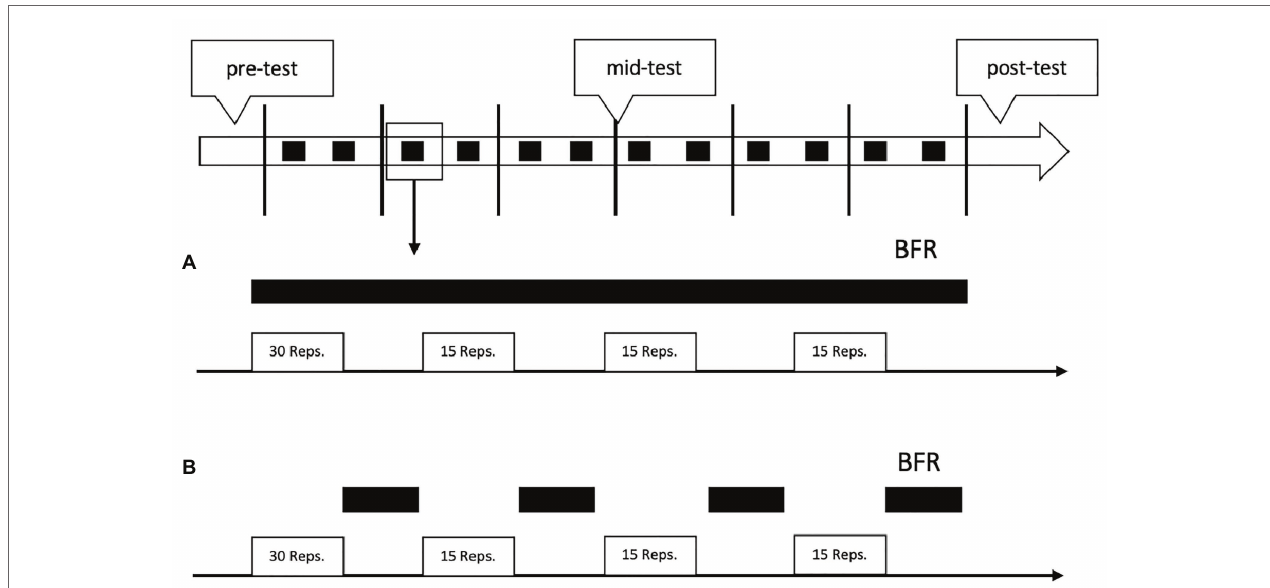
FIGURE 2 | Schematic overview of the study design and training protocol. The black squares in the top figure represent the blood-flow restriction (BFR)-trainings. The black bars in (A,B) indicate the time under BFR during each training. (A) represents the training regimen of the continuous BFR (cBFR) group and (B) the training regimen of the resting BFR (rBFR) group.